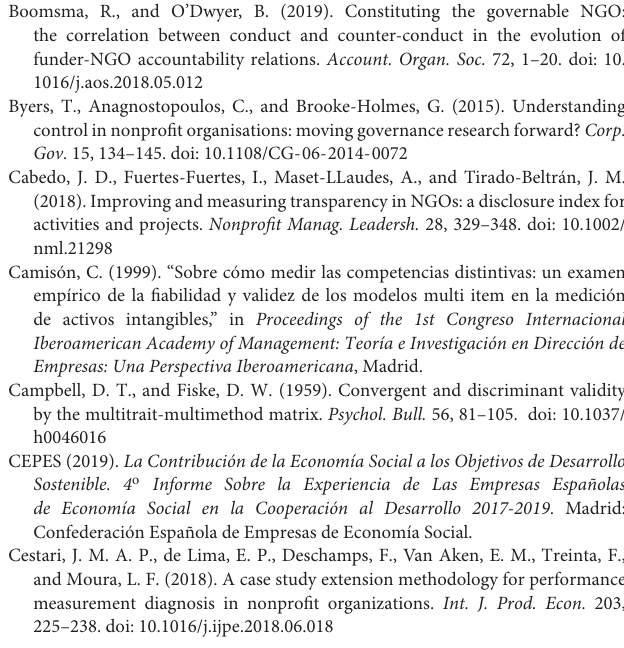
Supplementary Annex 1 | Budgetary and management control dimensions of once. Supplementary Annex 2 | Battery of indicators proposed for standardization. Supplementary Annex 3 |